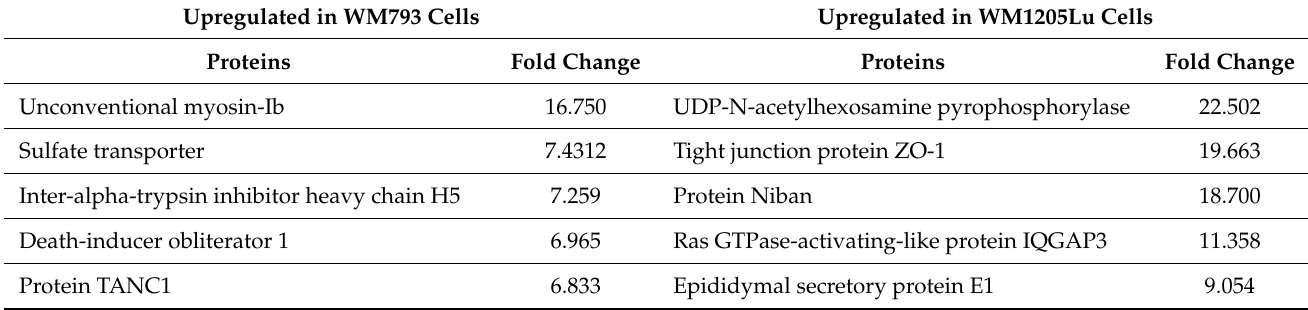
Table 5. Differentially expressed proteins within isogenic pairs of CM cells lines and CM-derived exosomes. Ten proteins with the highest fold change for CM cell lines and exosomes are listed in this table, while the entire LFQ analysis is presented in Supplementary